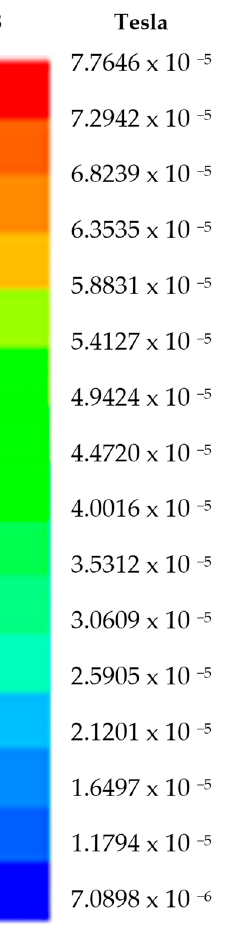
Figure 5. Magnetic field between the transmitting and receiving coils.